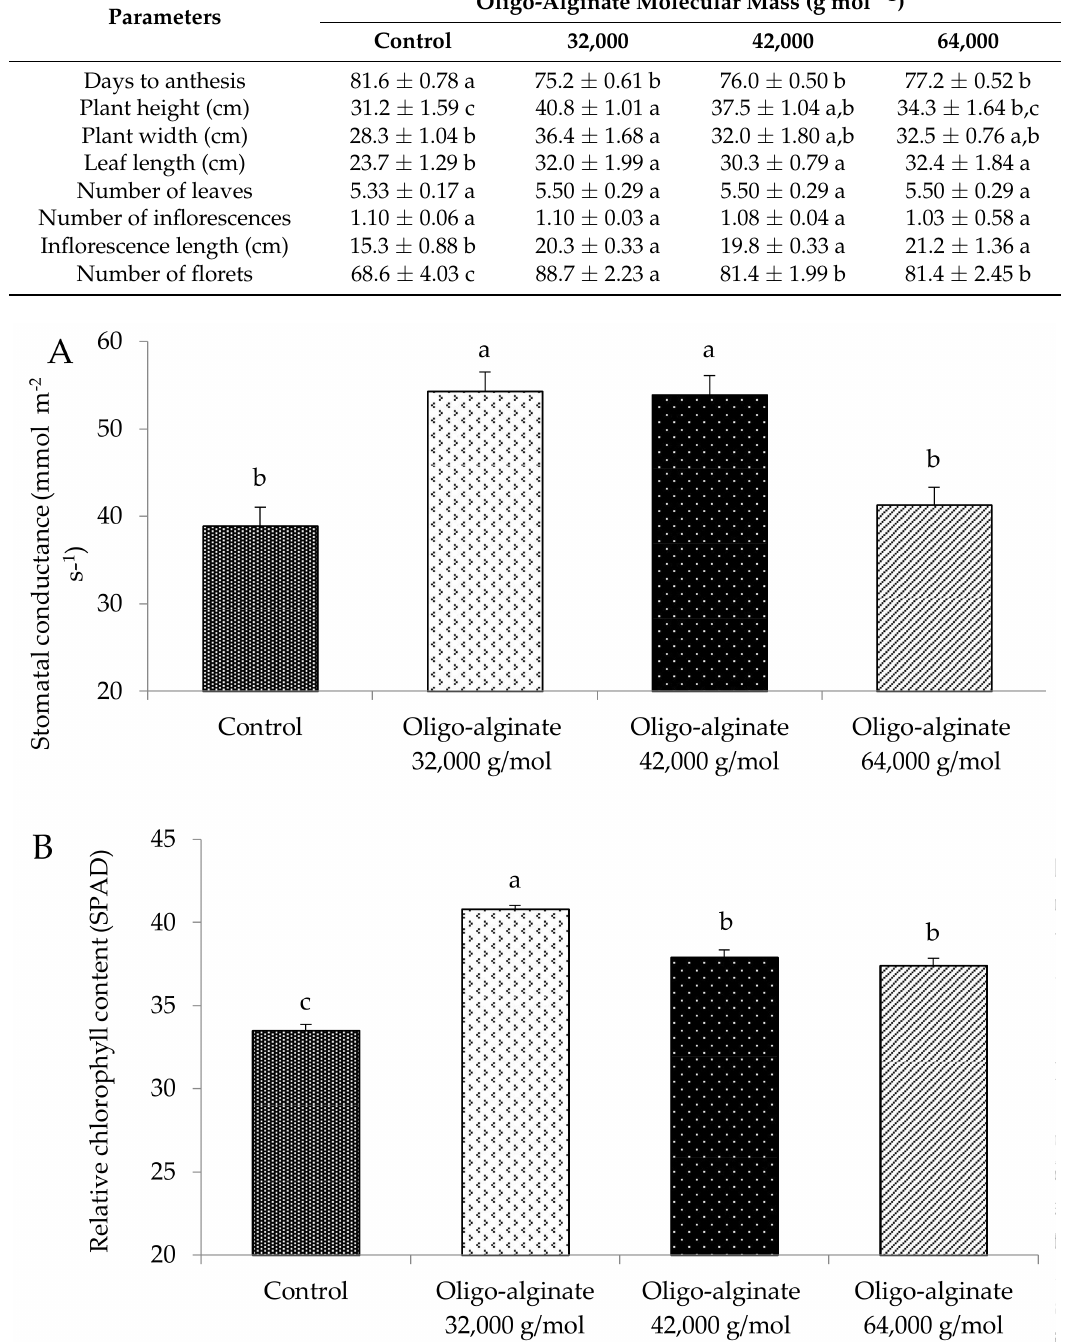
Figure 2. Effect of oligo-alginate with different molecular mass on stomatal conductance ( A ) and the relative chlorophyll content ( B ) of Eucomis autumnalis . Data are presented as means ( ± standard errors) and bars with different letters in each graph are significantly different by Tukey test ( p ≤